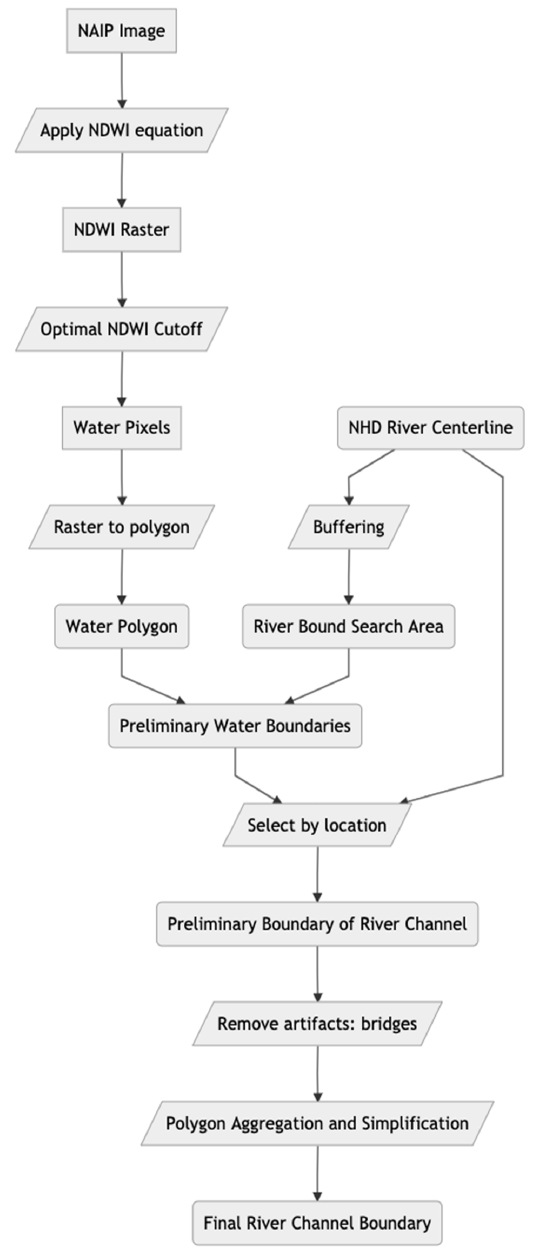
Figure 2. Flowchart of river channel delineation using NAIP images and NHD centerline data.